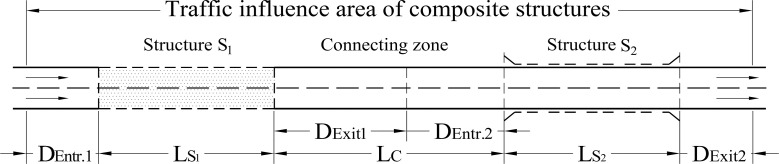
Diagram of traffic influence area of composite structures.